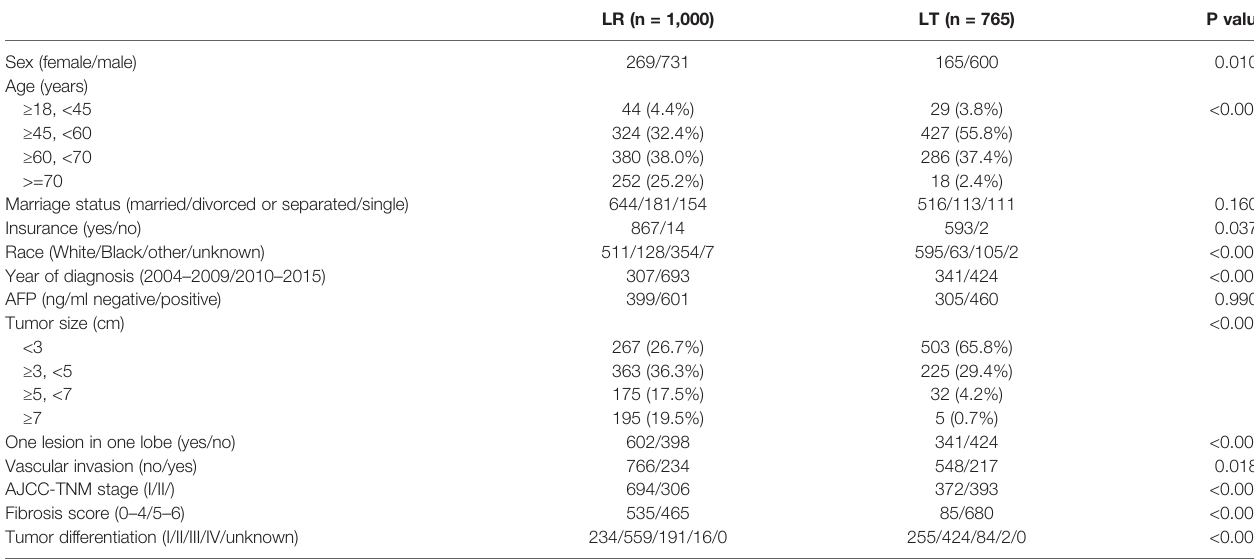
TABLE 1 | Characteristics of the entire study sample by treatment